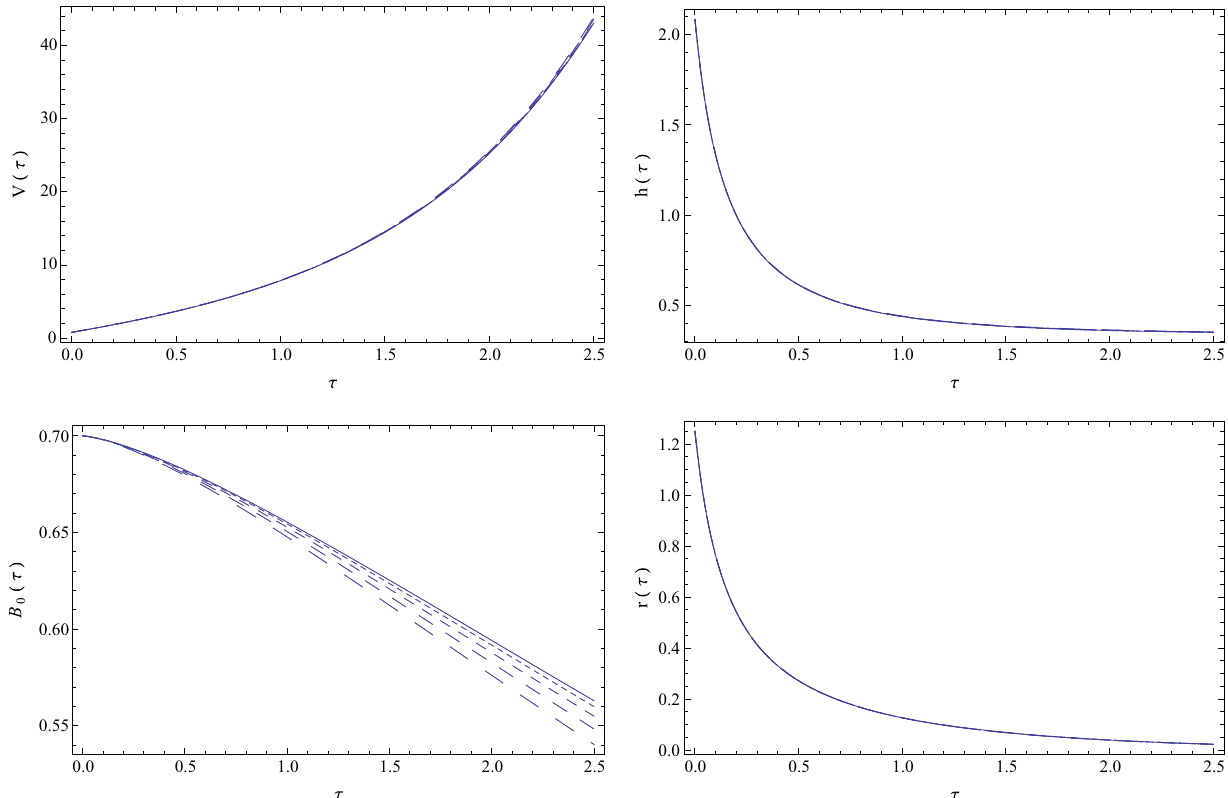
Fig. 3 Variationofthecomovingvolumeelement V ( upperleftfigure ), of the mean dimensionless Hubble function h ( upper right figure ), of the dimensionless vector field B 0 ( lower left figure ), and of the dimen- sionless matter energy density r for a dust fluid filled Bianchi type I Universe in the Maxwell–Chern–Simons theory, for different values of the parameter μ 0 : μ 0 = 0 . 10 ( solid curve ), μ 0 = 0 . 20, ( dotted curve ), μ 0 = 0 . 30, ( short dashed curve ), μ 0 = 0 . 40 ( dashed curve ),